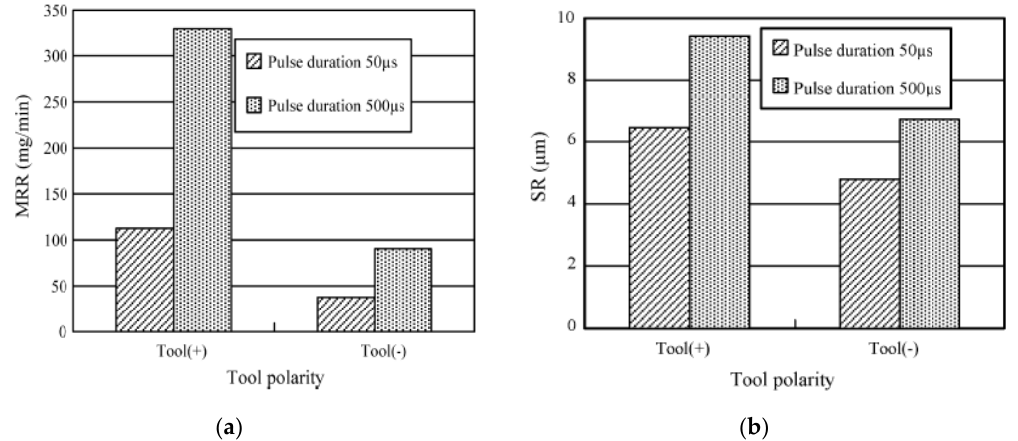
Figure 21. Effect of tool polarity on ( a ) MRR ( b ) surface roughness. (Reproduced with permission from [57]).